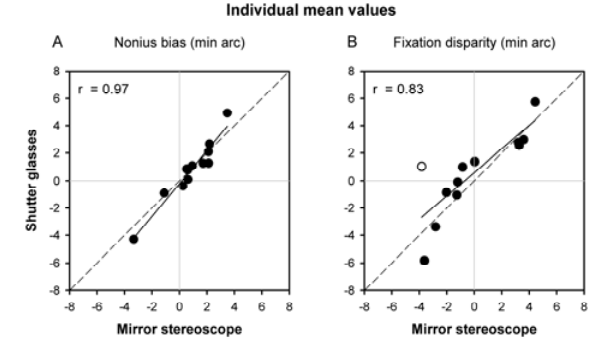
Figure 3. Each graph gives a comparison of shutter glasses and mirror stereoscope for the standard deviations of 8 subjects. These data refer to the objective measures, i.e the maximal ver- gence velocity and the response reached at a moment in time 400 ms after the disparity step stimulus. Convergent responses are shown by open symbols in the upper right quadrants, diver- gent responses by the closed symbols in the lower left quad- rants. Upper and lower graphs refer to the 1 deg and 3 deg dis- parity step stimulus. The identity line is shown as a reference.